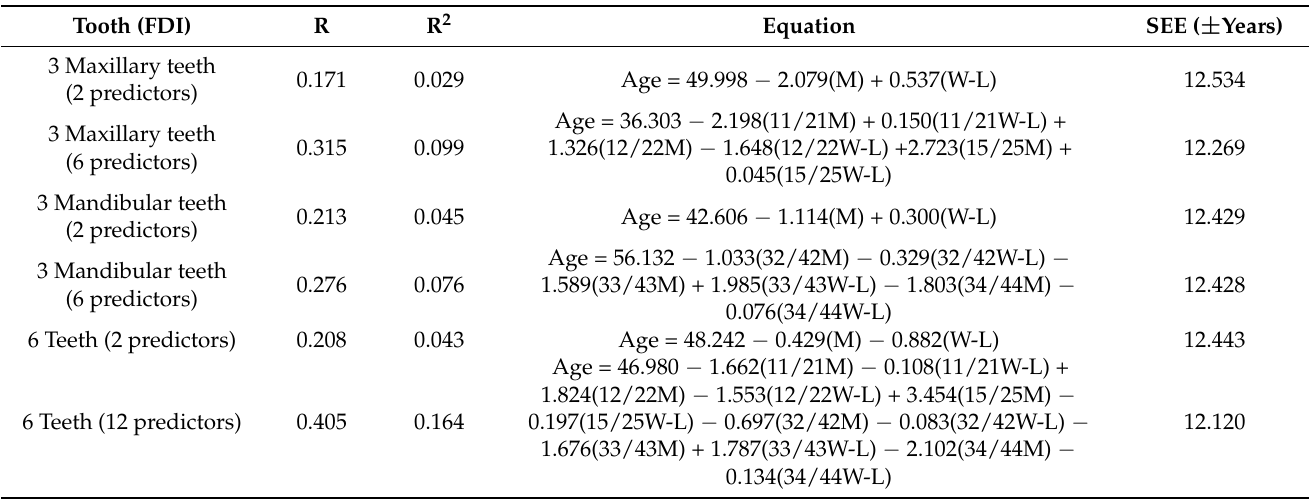
Table 5. Multiple regression models for the estimation of chronological age (in years) from the combined maxillary and mandibular teeth a .